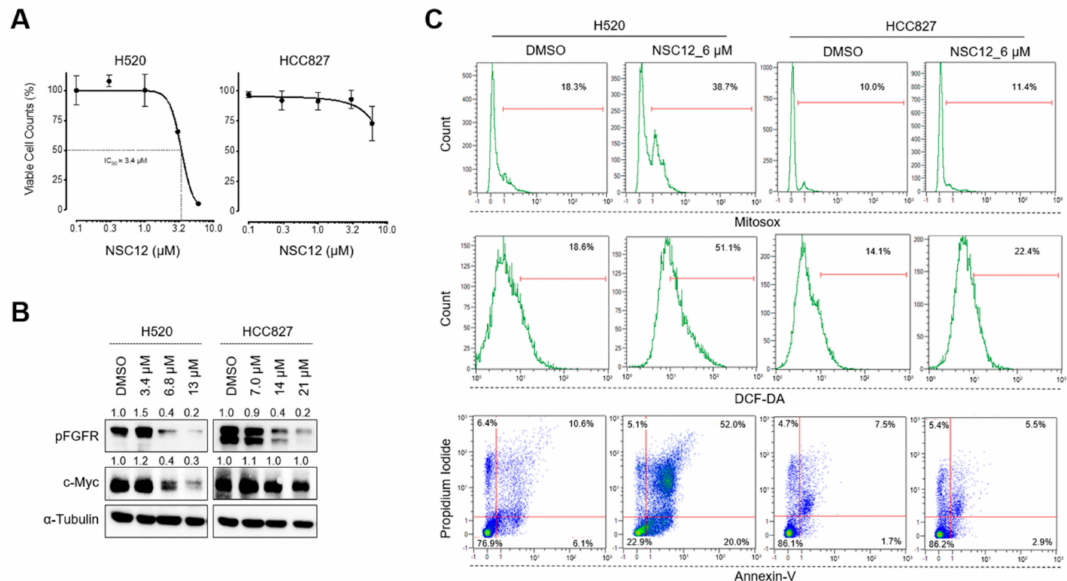
Figure 3. c-Myc downregulation and oxidative stress by FGF blockade is specific for FGF-dependent lung cancer cells. ( A ) H520 and HCC827 viable cell counts by flow cytometric analysis 48 h after treatment with increasing doses of NSC12. Data are mean ± SEM of 3 or more experimental replicates. ( B ) Western blot analysis of H520 and HCC827 cells after 3 h of treatment with increasing doses of NSC12. Densitometric quantification is reported above each band. ( C ) Cytofluorimetric analyses for mitochondrial or cytoplasmic ROS (reactive oxygen species) production and apoptosis by Mitosox, DCF-DA and propidium iodide / Annexin-V stainings,